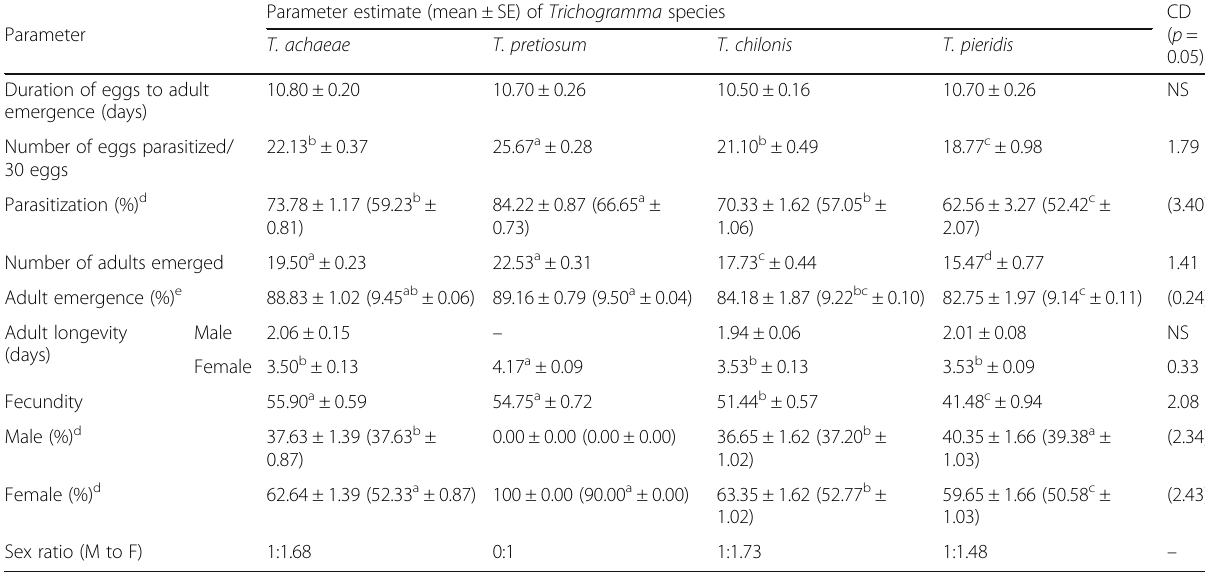
Table 1 Biological parameters of Trichogramma spp. (second generation) on Tuta absoluta eggs in tomato